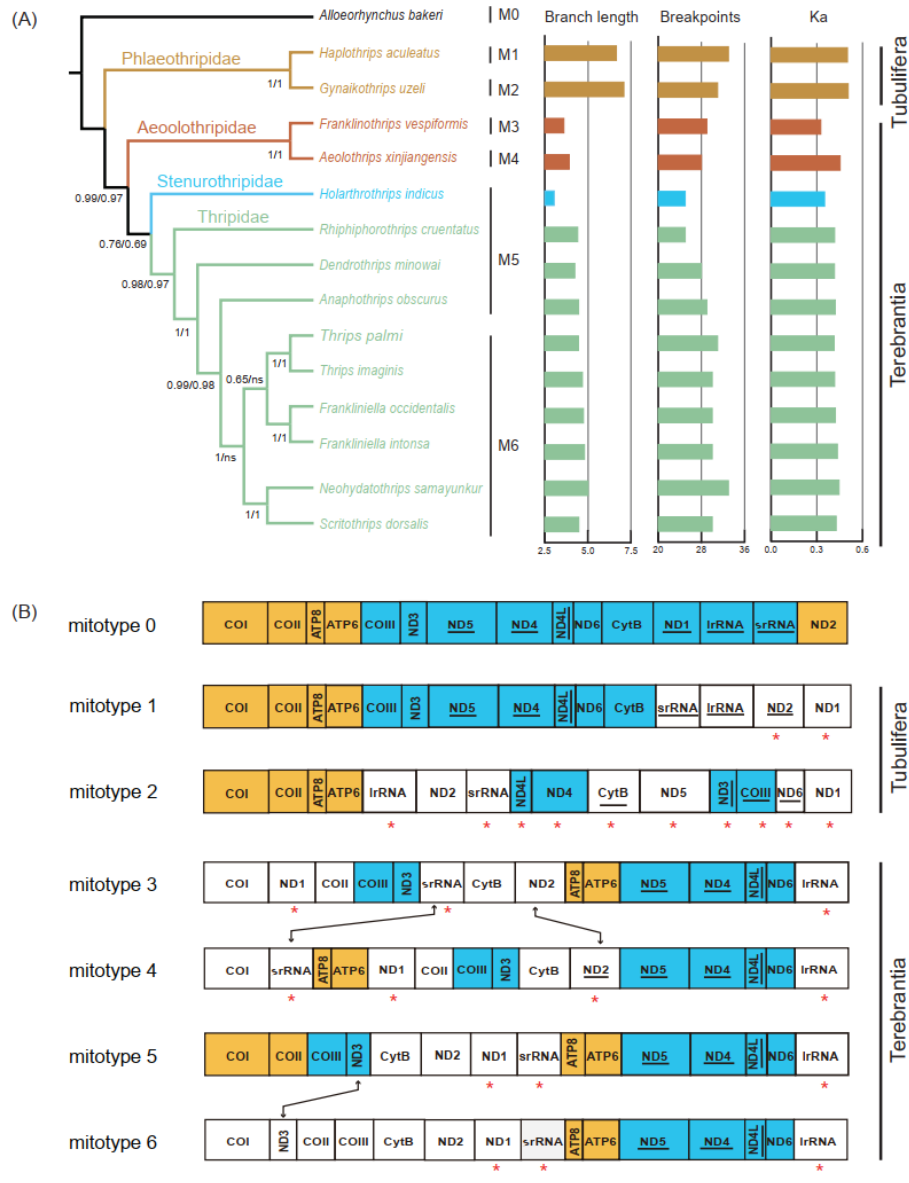
Figure 4. ( A ) The gene rearrangement rates and nucleotide substitution rates of the selected Thysanoptera. Phylogenetic trees were inferred from PhyloBayes. The Bayesian posterior probabilities of the PhyloByayes tree inferred from the PCG and PCG12 datasets were separated by “/”, and the branch lengths are shown on the right side. Different colors indicate data for different families. The mitotypes 0 – 6 were represented by M0 – M6. Ka, the values of the non-synonymous substitution rate. ( B ) Arrangement of the major genes in the mitogenomes used in this study. Mitotype 0 was accessed from the mitogenome of the putative insect ancestor, and the remainder were accessed from the mitogenomes of 14 thrips. Compared to mitotype 0, identical gene blocks are colored, and the inversed gene is highlighted by an asterisk “*”. Gene rearrangement between mitotypes is indicated by double arrow lines.